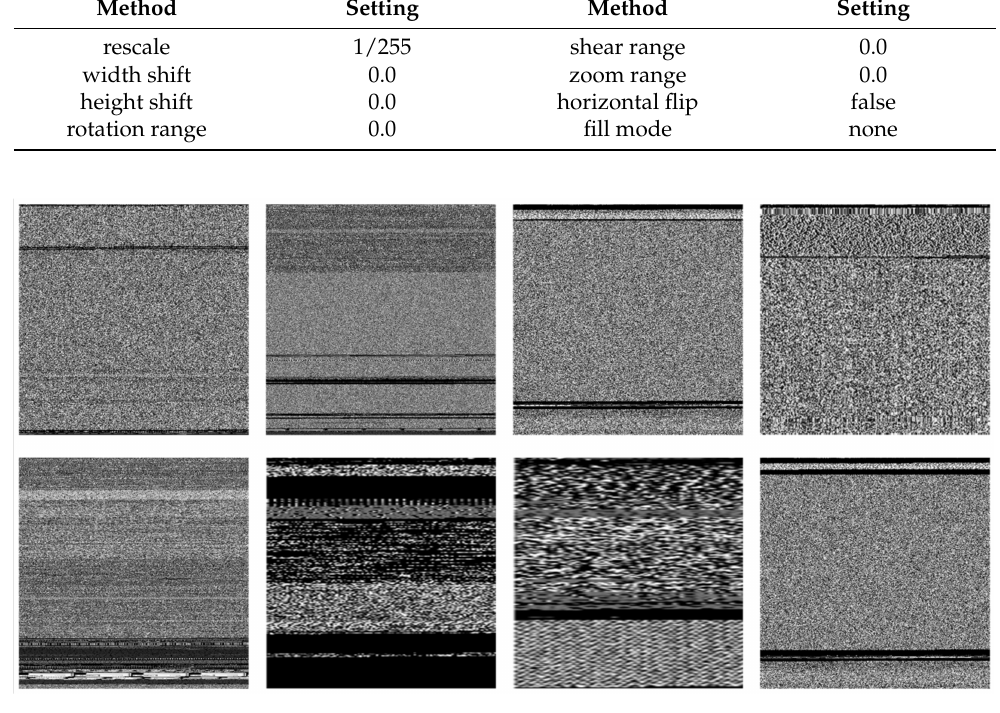
Figure 4. Partial malware images after data